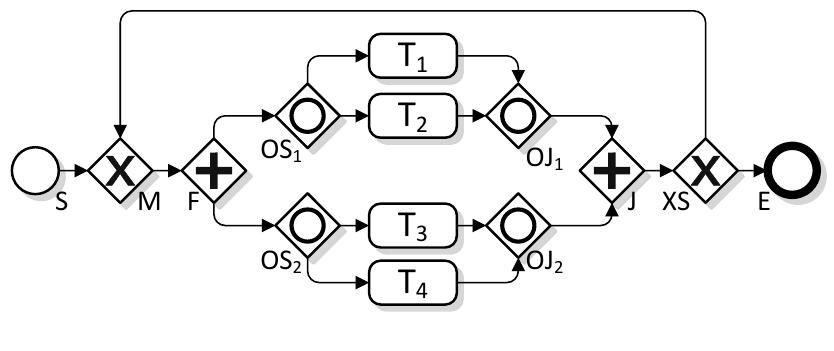
Figure 11. A structured process with an